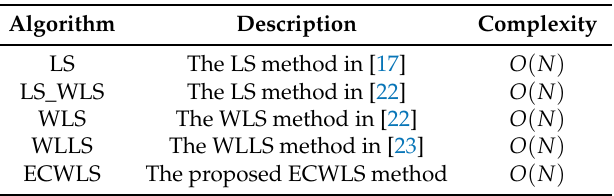
Table 1. Complexities of all